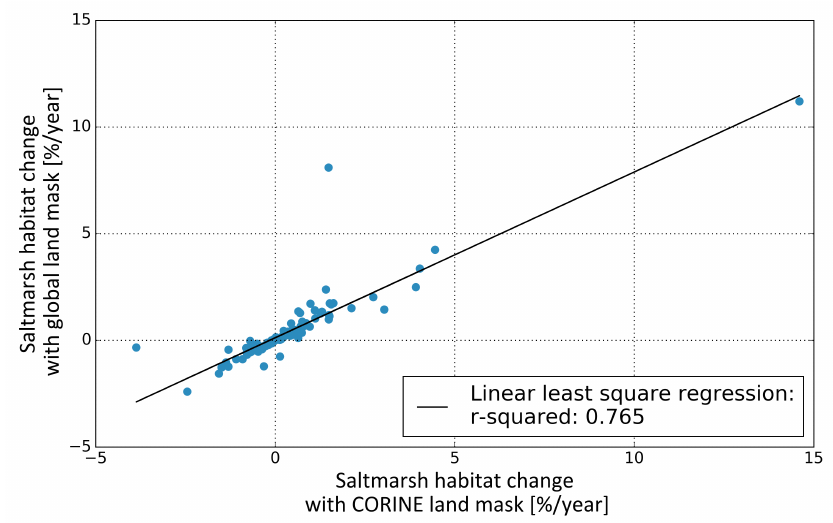
Figure 10. Correlation between saltmarsh trends (%/year) resulting from decision tree (DT) classification using CORINE data set as land mask (European land mask solution) on the x -axis and relative saltmarsh trends resulting from DT classification using the produced global land mask (global land mask solution) on the y